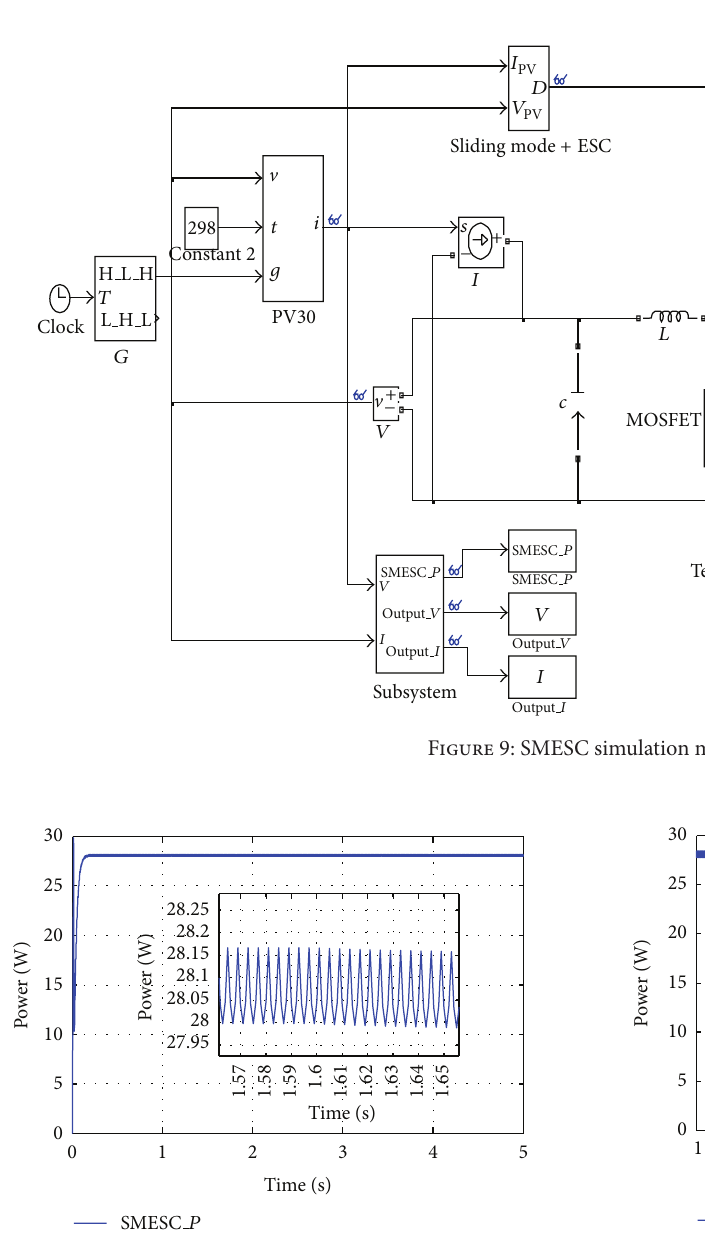
Figure 10: Simulation results for SMESC performance given uni- form irradiance of 1000W/m 2 .